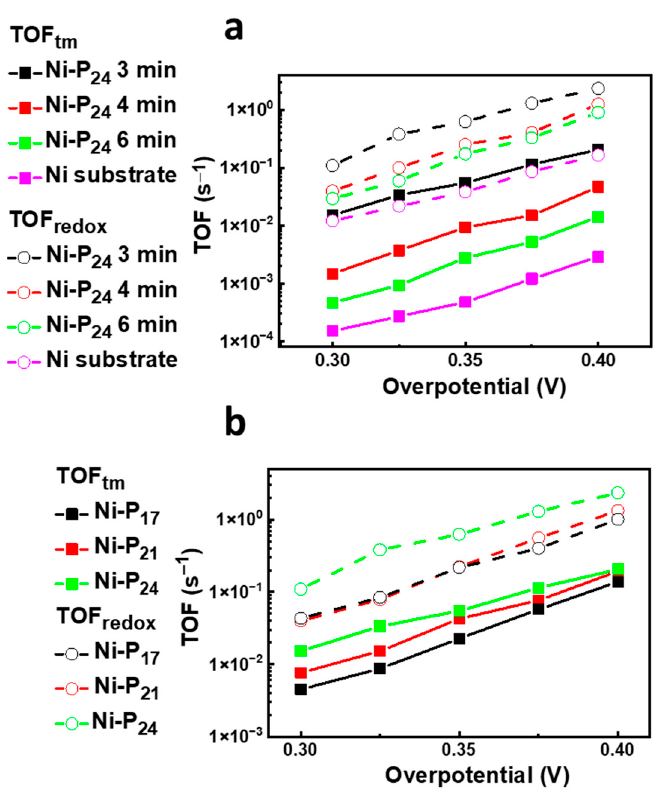
Ni–P coatings with different percentages of phosphorus deposited for 3 Figure 4. TOF tm and TOF redox of ( a ) Ni–P 24 samples deposited at different growth times, and ( b ) Ni– P coatings with different percentages of phosphorus deposited for 3 min.